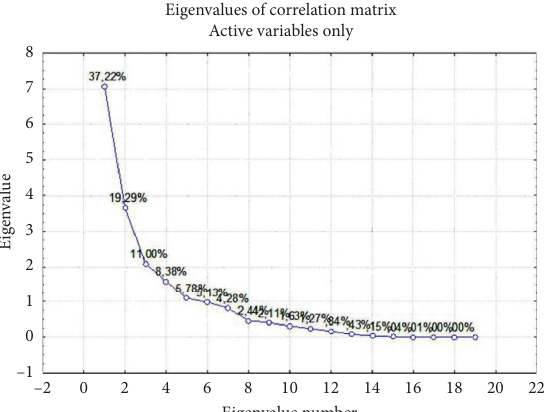
Figure 2: Te percentage of variance expressed by each principal component of the Angads aquifer in September 2020.